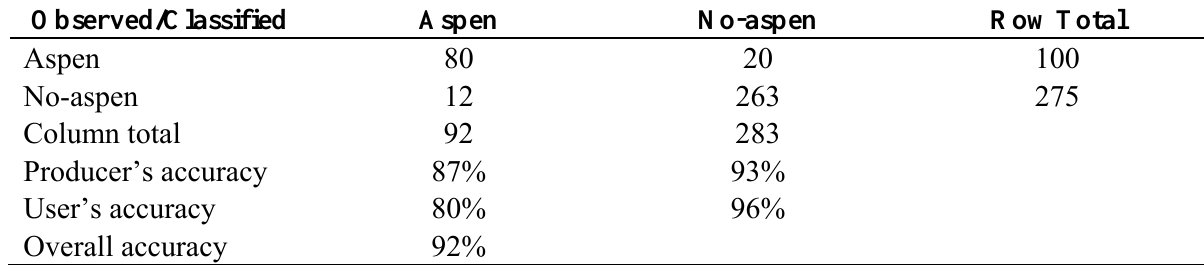
Table 2. 2005 Landsat image classification accuracy